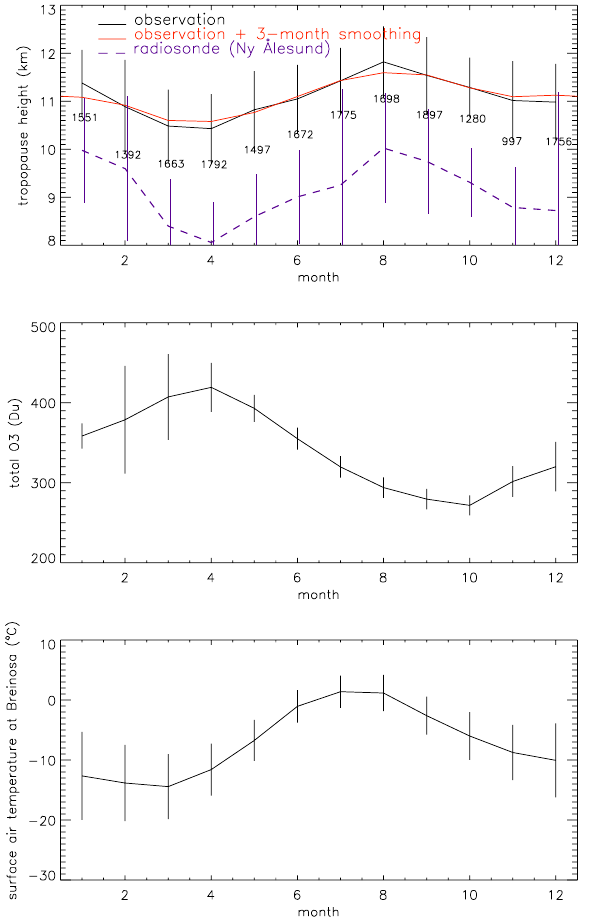
Fig. 5. Upper panel: repetition of Fig. 2, but included here to show seasonal variation in the contexts of those of ozone and tempera- ture. Middle panel: monthly climatology of total column O 3 in Dobson units, as measured at Ny ˚Alesund. Bottom panel: monthly climatology of surface air temperature at Breinosa. Vertical bars in- dicate standard deviations corresponding to the monthly means; in the upper panel numbers on the standard deviation bars indicate the numbers of tropopause determinations used in each mean.